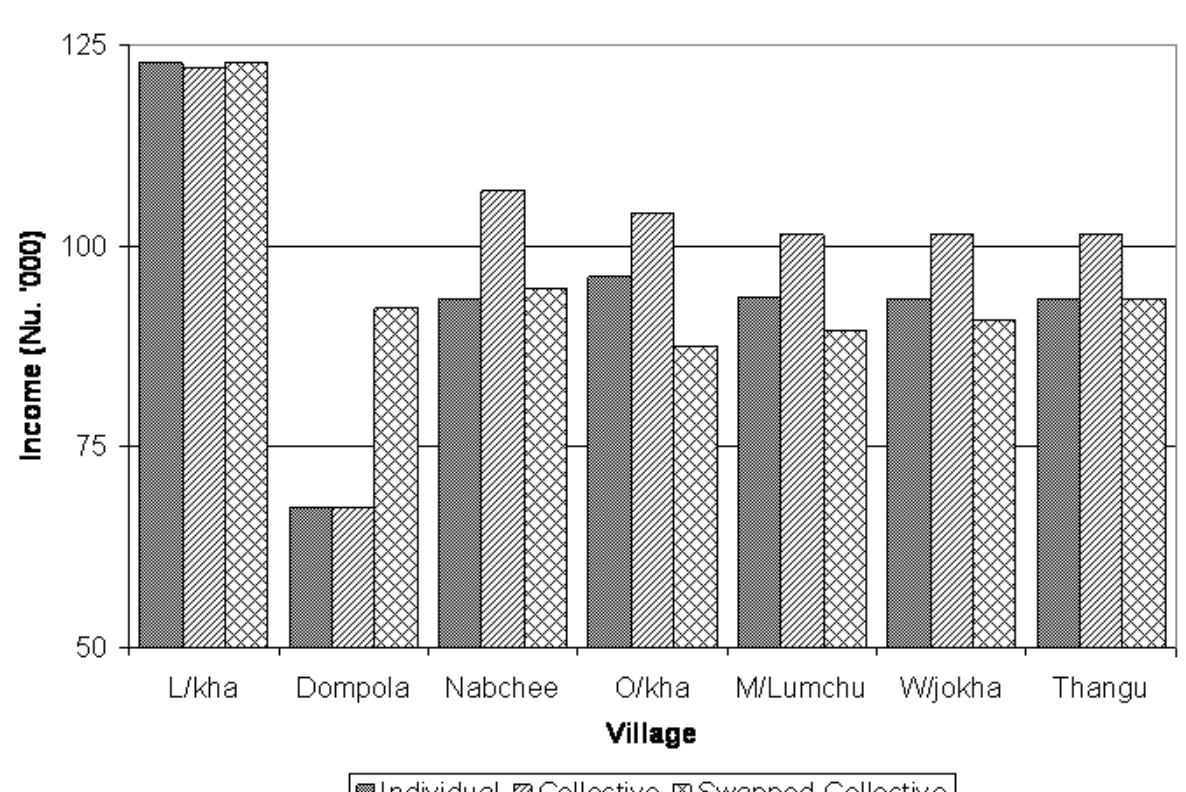
Fig. 12. Average individual